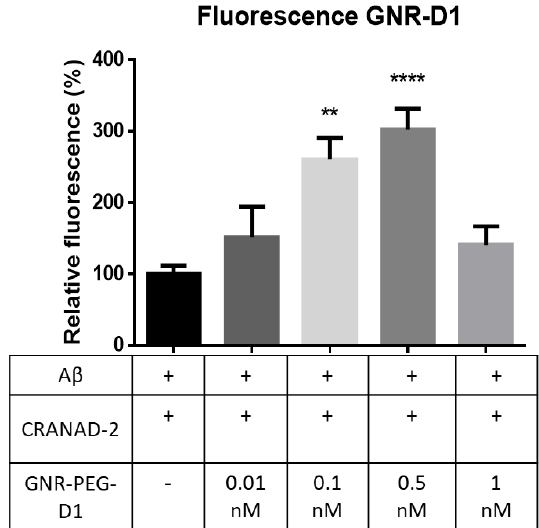
Figure 7. Increase in fluorescence intensity for samples obtained by using CRANAD-2 with GNR-PEG-D1 of different concentrations, at a wavelength of 640 nm and 715 nm. Error bars represent SEM, n = 3; t -test was used for the statistical analysis to compare baseline values with those obtained values. ** p = 0.0011 and **** p < 0.0001.